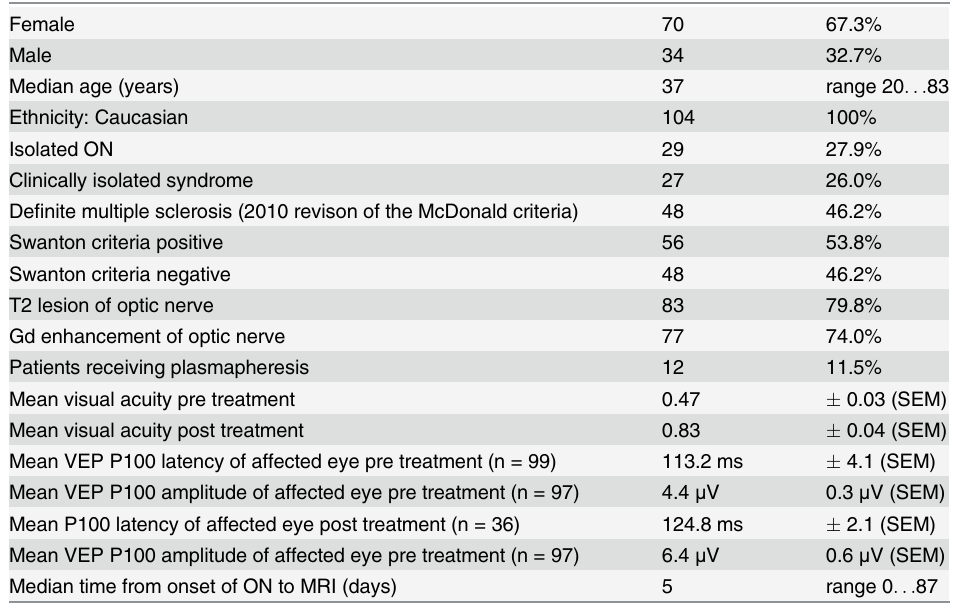
Table 2. Characteristics of the study cohort.